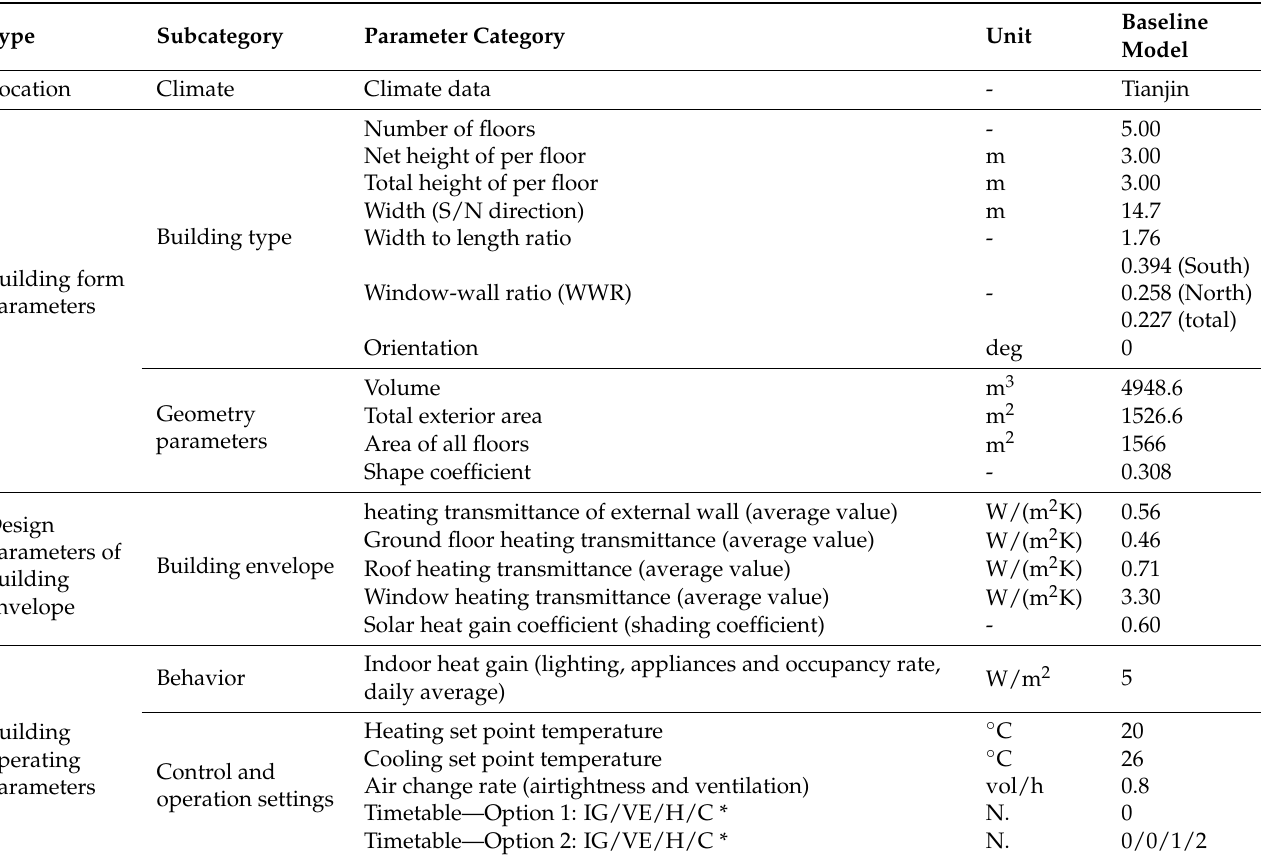
Table 4. Parameters of the baseline model.